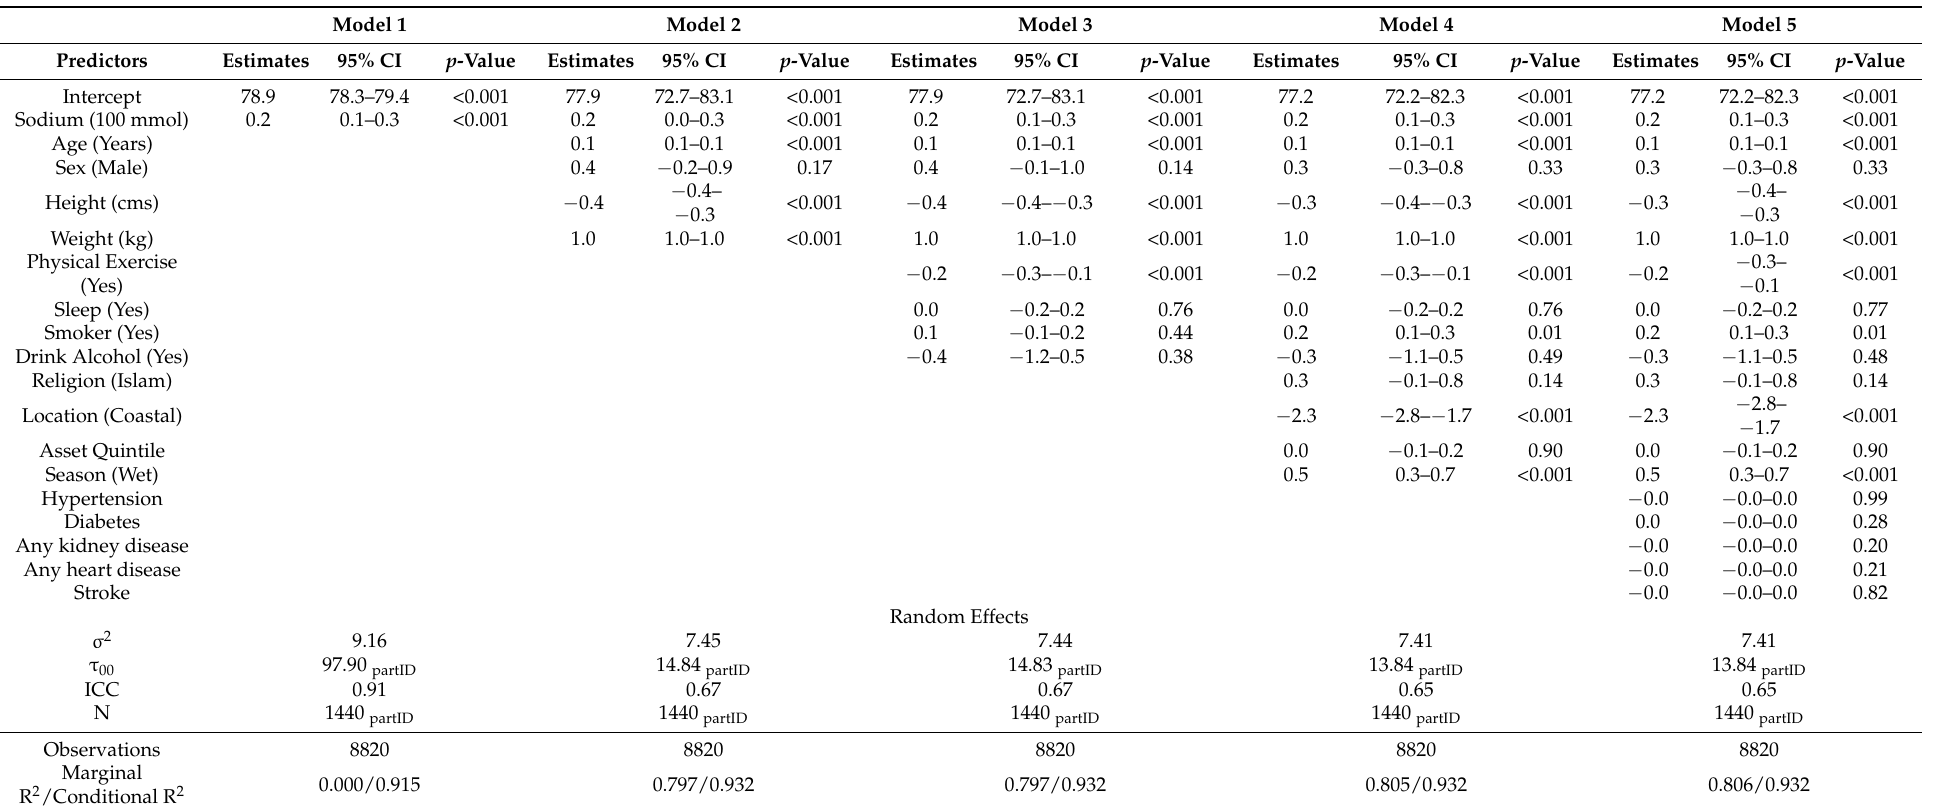
Table 2. Association between 24 h urinary sodium and mean waist circumference